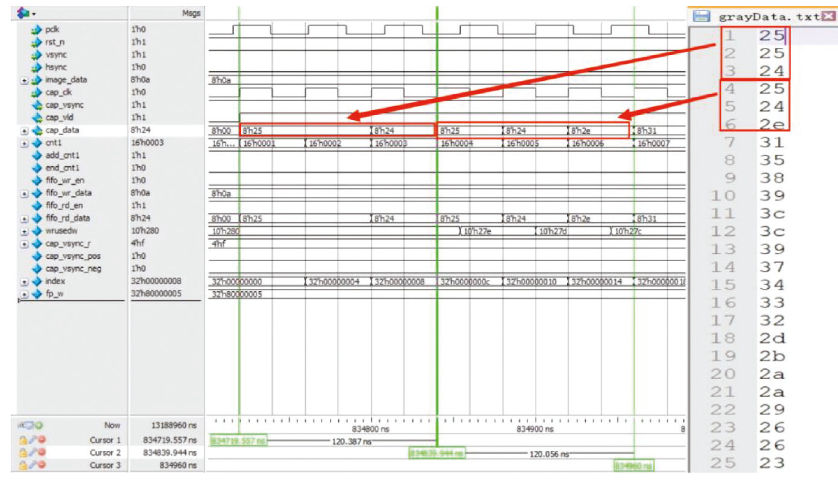
Figure 8: Video capture simulation